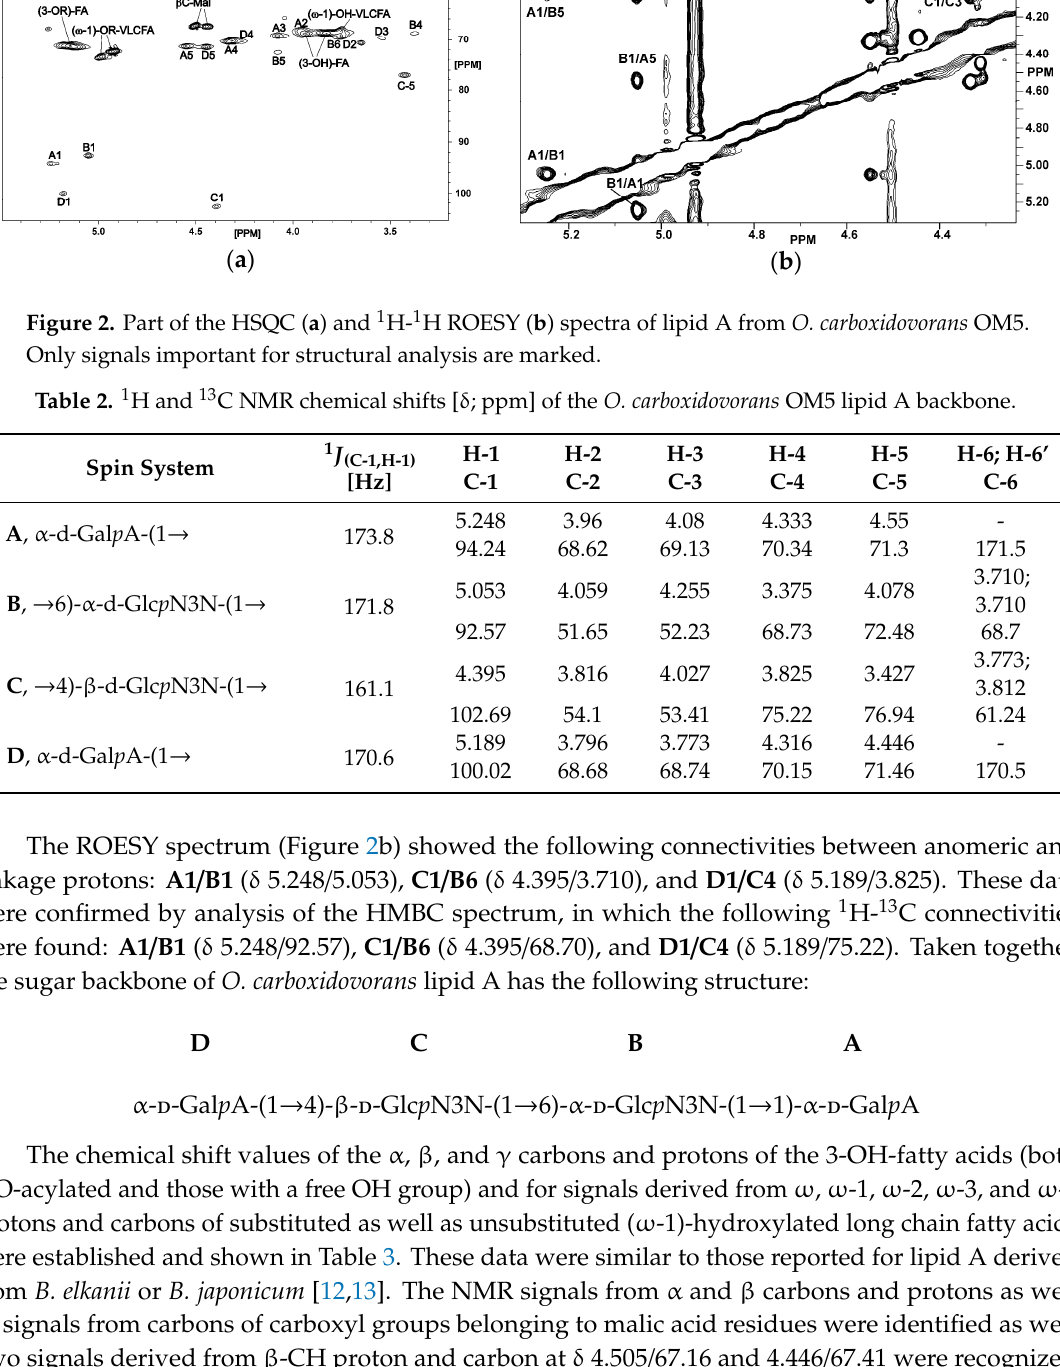
interresidue correlation with ( ω -1)-hydrogens ( δ 4.929 and 4.996, respectively) from the long chain fatty acids in the HMBC spectrum. The signals of the β -CH group of unsubstituted 3-hydroxy fatty acids were identified at δ 3.833 / 68.80 and 3.942 / 68.80. Two signals derived from the β -CH proton